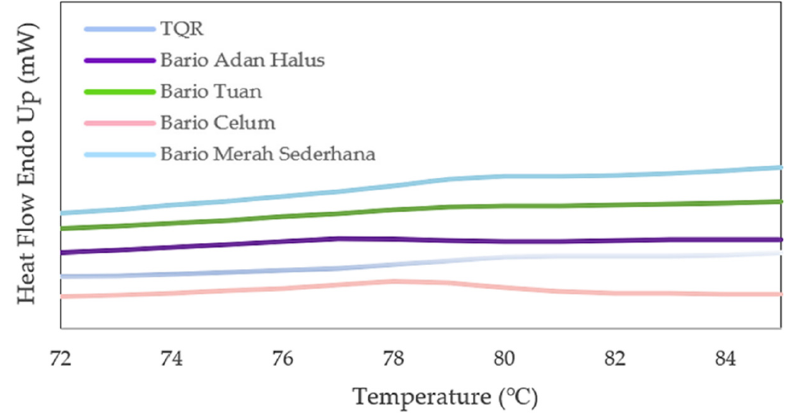
Figure 2. DSC curve of gelatinised rice flour samples for TQR, Bario Adan Halus, Bario Tuan, Bario Celum, and Bario Merah Sederhana.